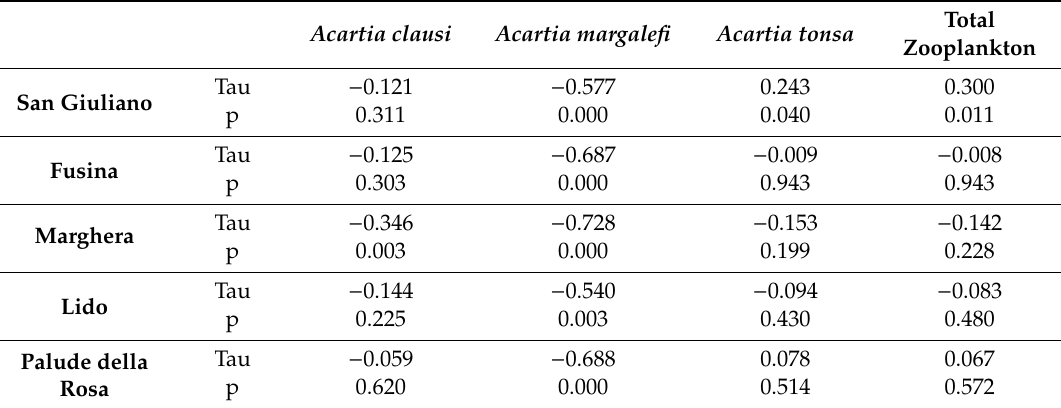
Table 1. Results of the seasonal Kendall test (1997–2002 period).